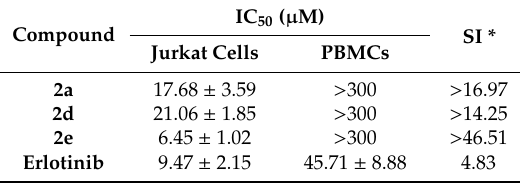
Table 2. The cytotoxicity of compounds 2a , 2d , and 2e against Jurkat cells and